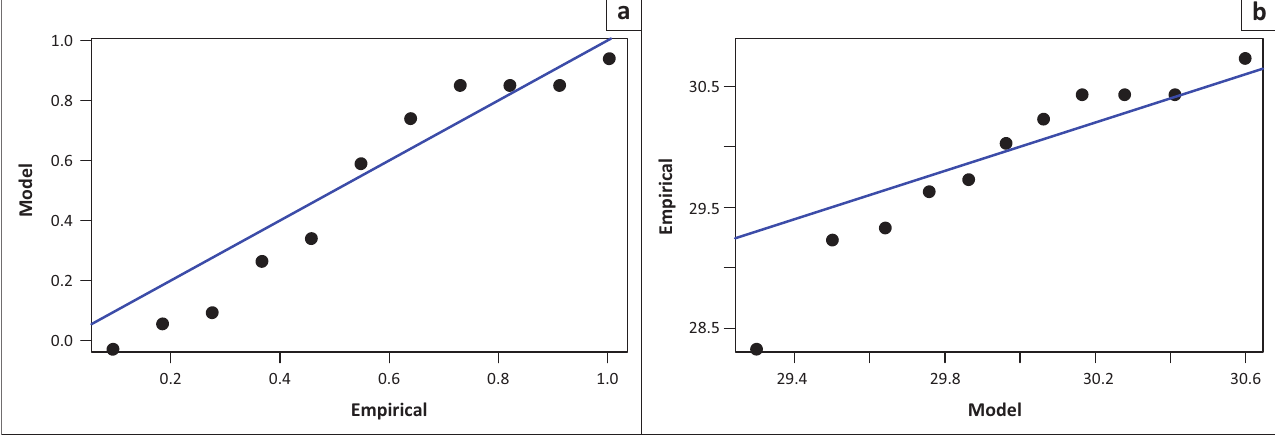
FIGURE 2-A1: Diagnostic plots illustrating the fit of the data (annual average maximum temperature) to the generalised extreme value distribution for r largest order statistics model with k = 5 and k = 6, (a) probability–probability plot for k = 5, (b) quantile–quantile plot for k = 5, (c) probability–probability plot for k = 6, and (d) quantile–quantile plot for k =